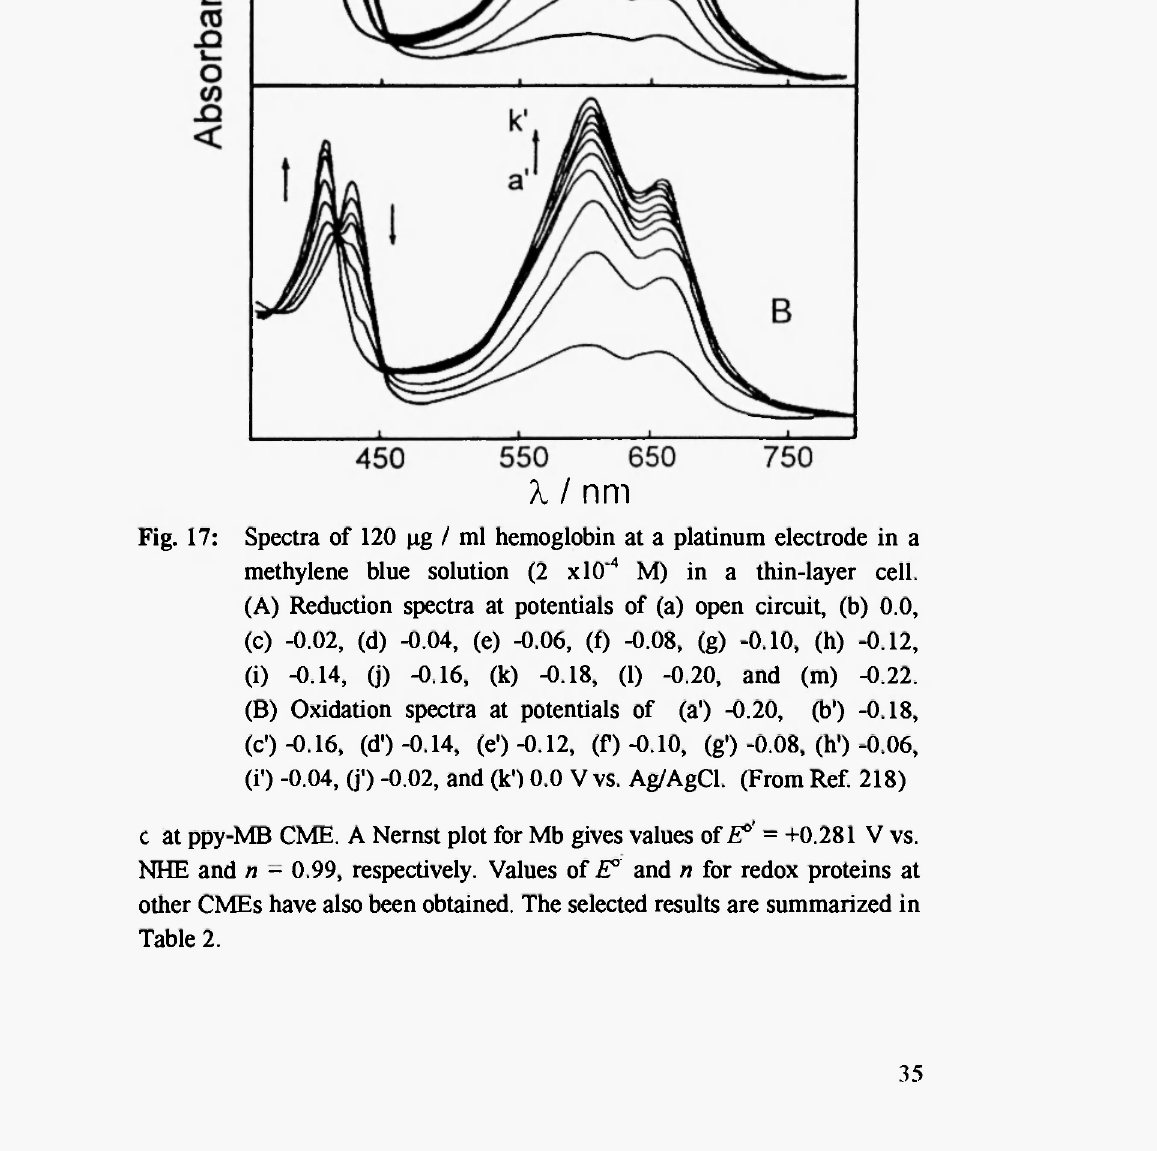
λ / nm Fig. 17: Spectra of 120 μg / ml hemoglobin at a platinum electrode in a methylene blue solution (2 xlO" 4 M) in a thin-layer cell. (A) Reduction spectra at potentials of (a) open circuit, (b) 0.0, (c) -0.02, (d) -0.04, (e) -0.06, (f) -0.08, (g) -0.10, (h) -0.12, (i) -0.14, (j) -0.16, (k) -0.18, (1) -0.20, and (m) -0.22. (B) Oxidation spectra at potentials of (a 1 ) -0.20, (b') -0.18, (c') -0.16, (d') -0.14, (e') -0.12, (f) -0.10, (g') -0.08, (h') -0.06, (i') -0.04, (j') -0.02, and (k') 0.0 V vs. Ag/AgCl. (From Ref. 218) c at ppy-MB CME. A Nernst plot for Mb gives values of E°' = +0.281 V